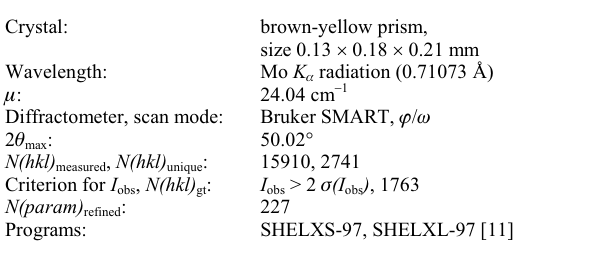
Table 1. Data collection and